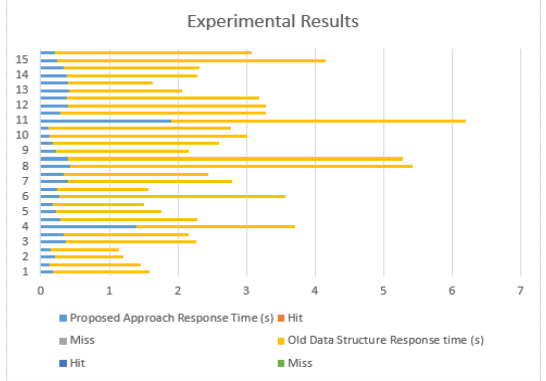
Fig. 2. Experimental Results Request Time.